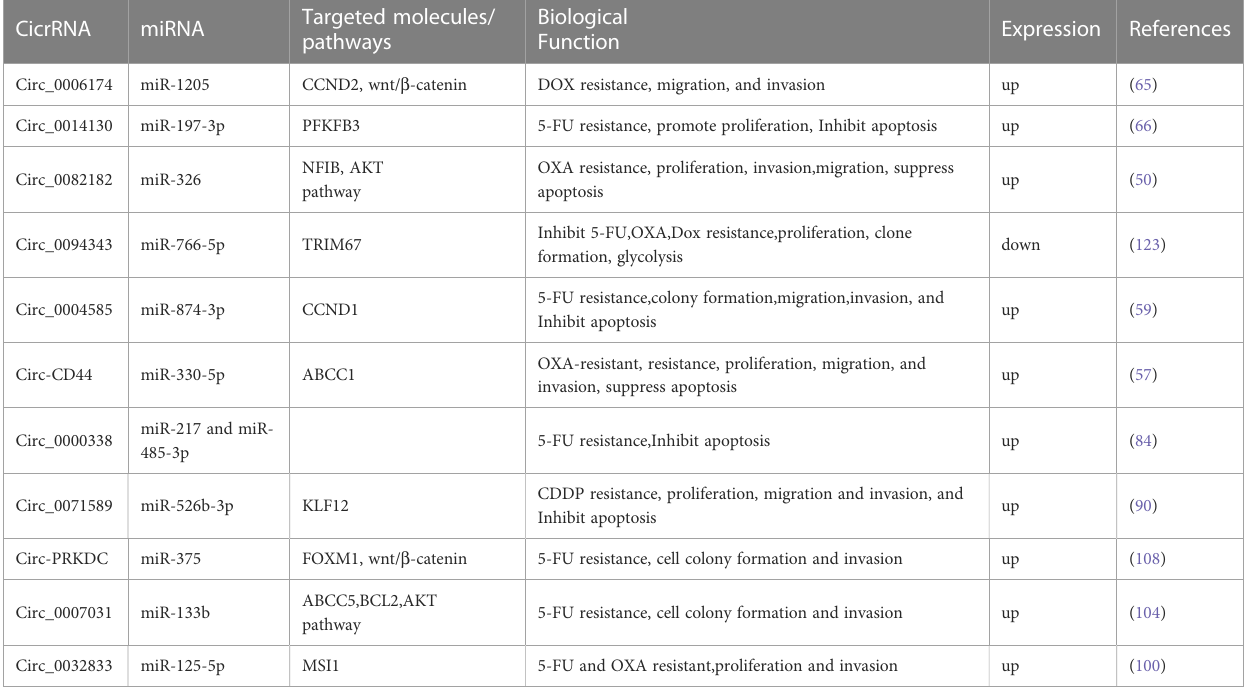
TABLE 3 CircRNAs upregulated or downregulated in CRC, with the implication in therapy